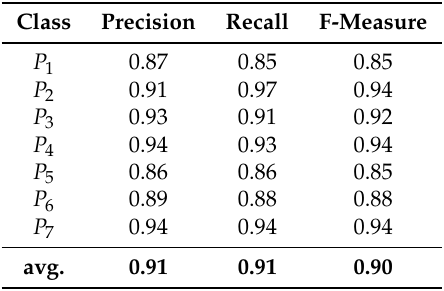
Table 9. Precision, Recall, and F-measure of the proposed model for subject-independent position detection. Class Precision Recall F-Measure P 1 0.87 0.85